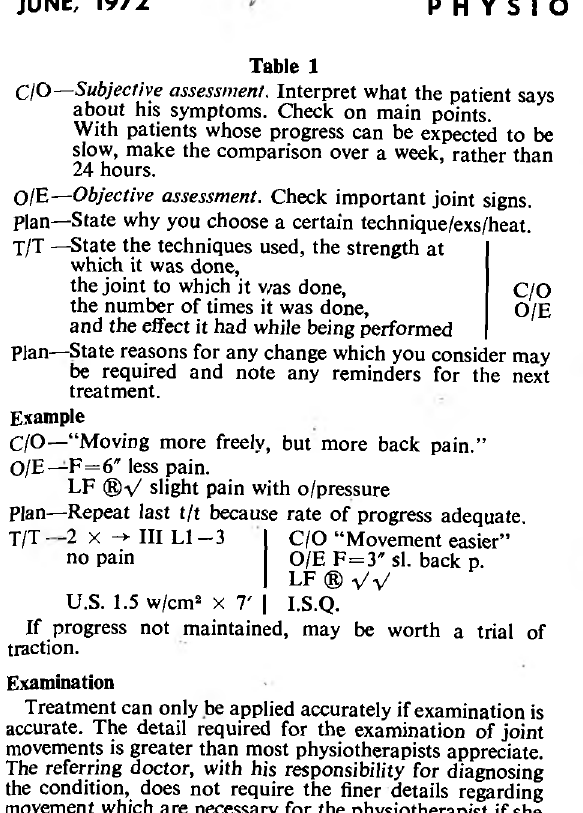
CIO-Subjective assessment. Interpret what the patient says about his symptoms. Check on main points. With patients whose progress can be expected to be slow, make the comparison over a week, rather than 24